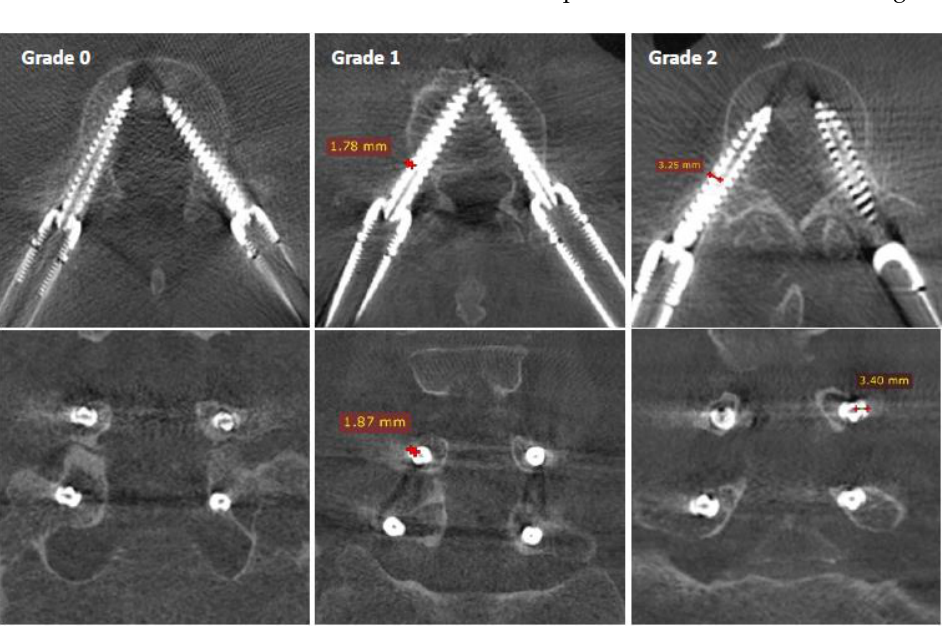
Figure 3. Screw placement accuracy with the pedicle according to Gertzbein and Robins: Grade 0 is perfectly contained within the pedicle, Grade 1 represents a cortical encroachment <2 mm, and Grade 2 is a breach between 2 and 4